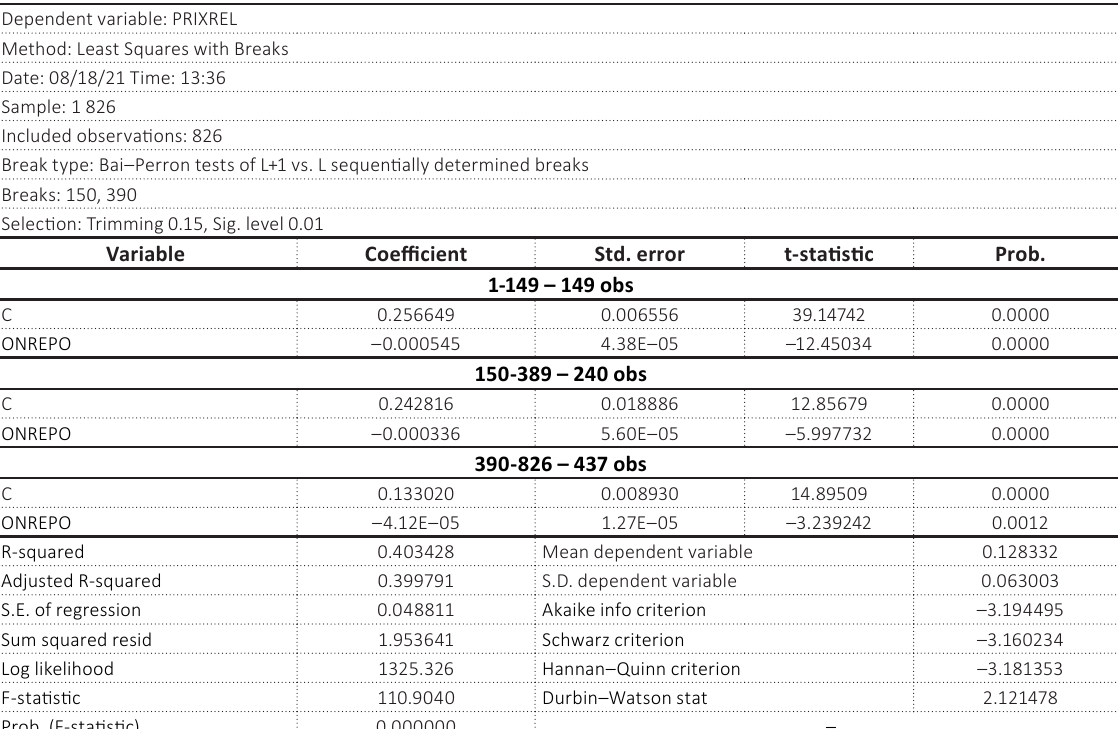
Table 3. Segmented regression output of relative price subject to net excess liquidity